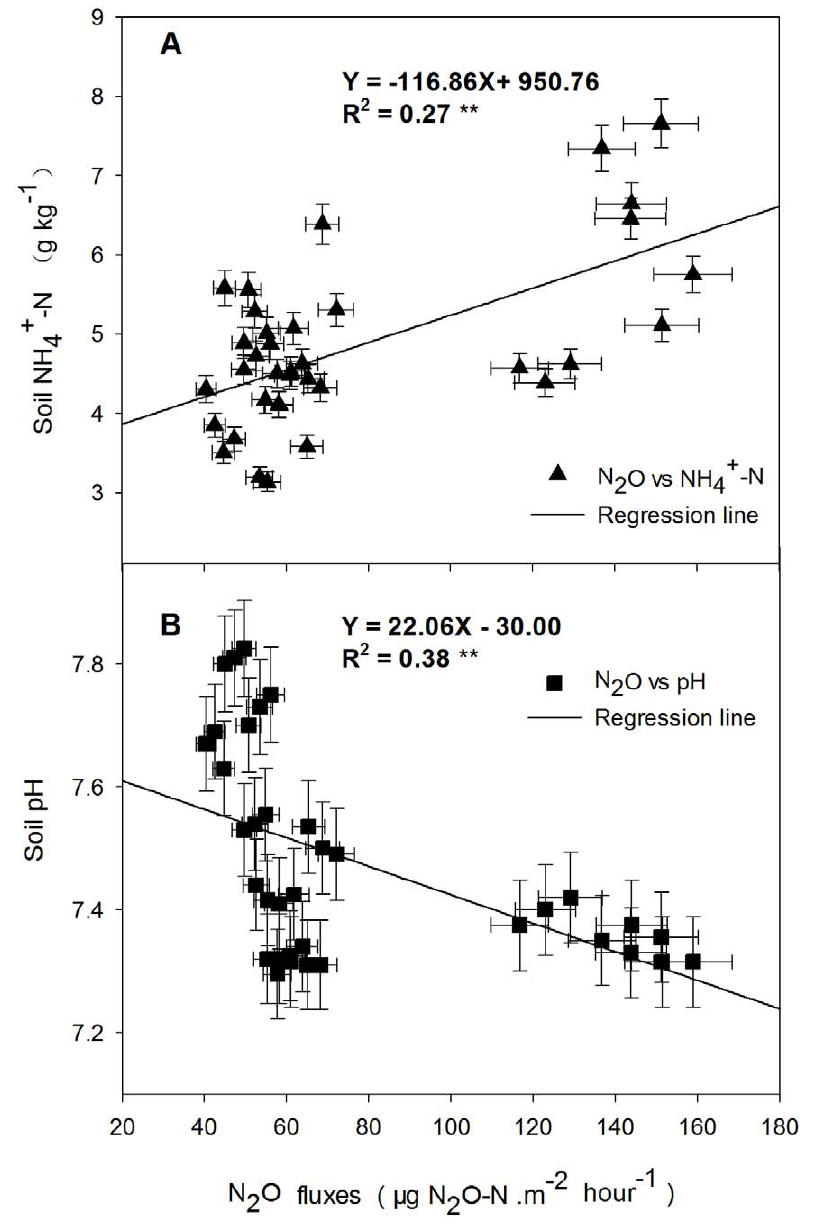
Figure 4. A Linear regression between the N 2 O emission fluxes and soil NH 4 + -N, B Linear regression between the N 2 O emission fluxes and soil pH. Arrows indicate the regression equation between the N 2 O emission fluxes and soil NH 4 + -N, soil pH. **indicates P ,